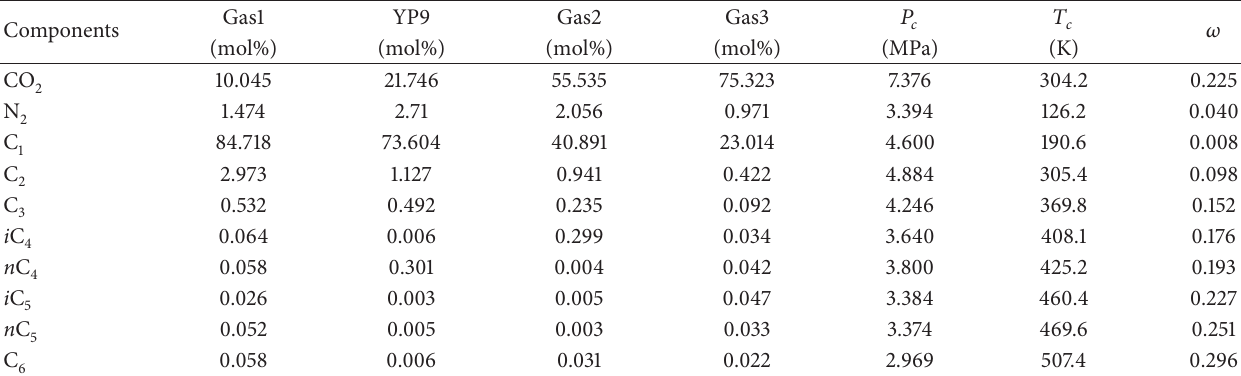
Table 2: Composition of various gas mixtures and the critical properties of the related component.